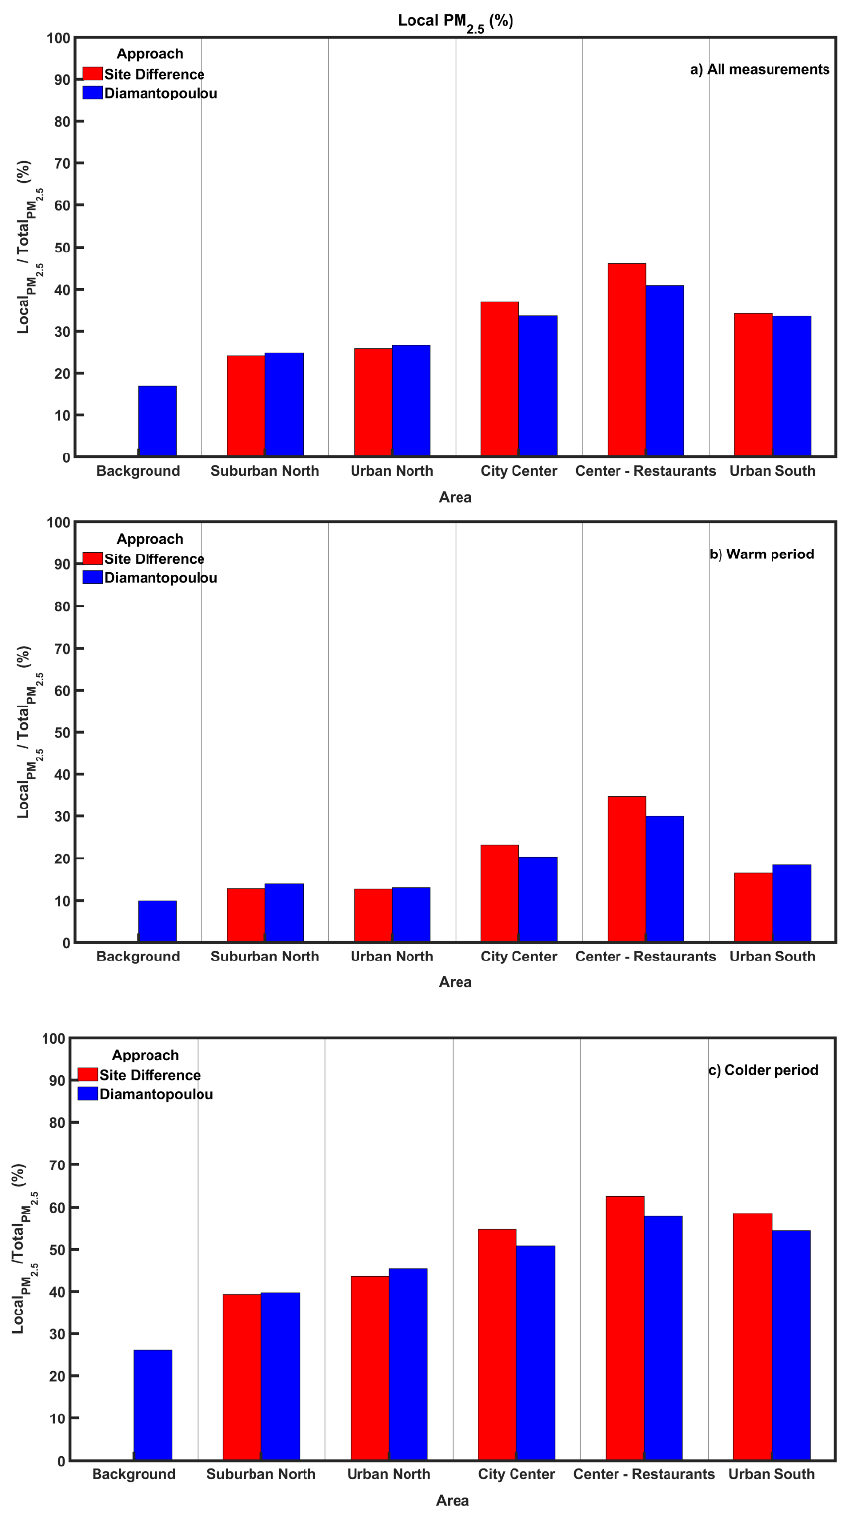
Figure 9. Average percent contribution of the local sources to the measured PM 2.5 in all areas in Patras during the ( a ) full study, ( b ) warm period, and ( c ) colder period.